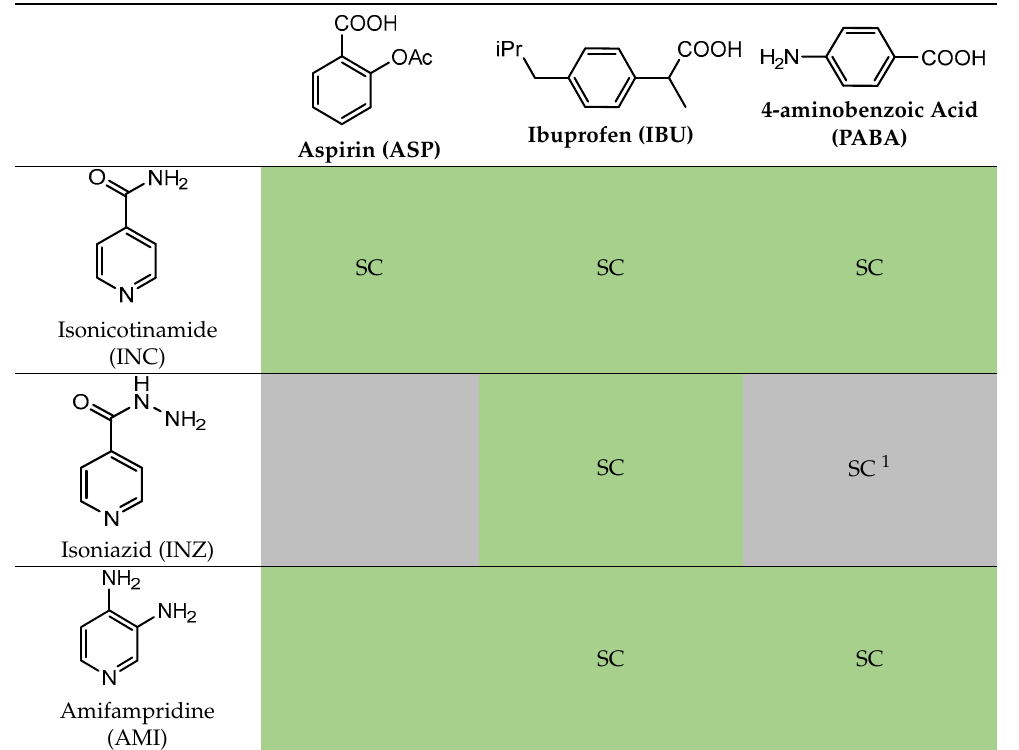
Table 1. Complexation screening results. Green stands for the successful mechanochemical combi- nation; grey means an oil-like product was obtained. SC means the combination was confirmed by structural analysis of a single crystal (SC).